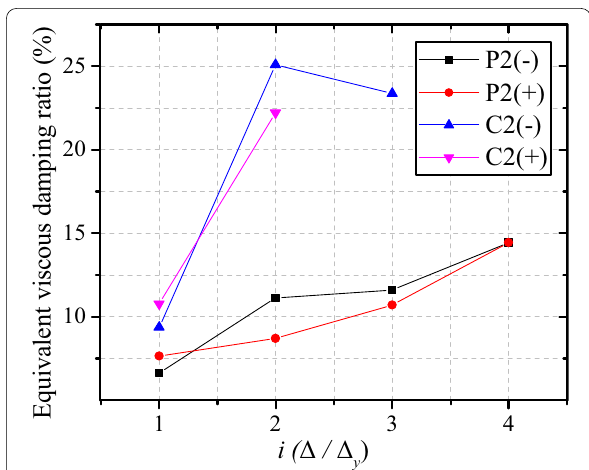
Fig. 23 Equivalent viscous damping ratio of the